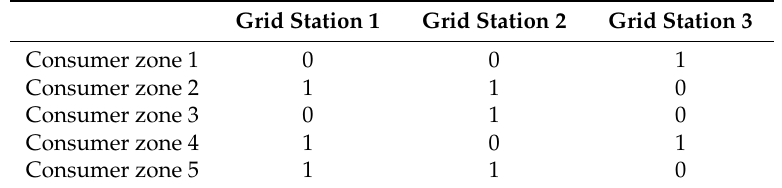
Table 7. Optimal values of binary variables for the second part of the supply chain.